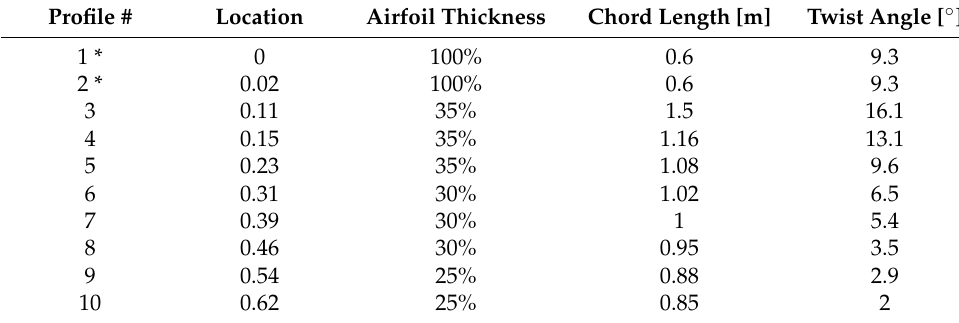
Table 6. Geometric section parameters of the optimised 13 m wind turbine